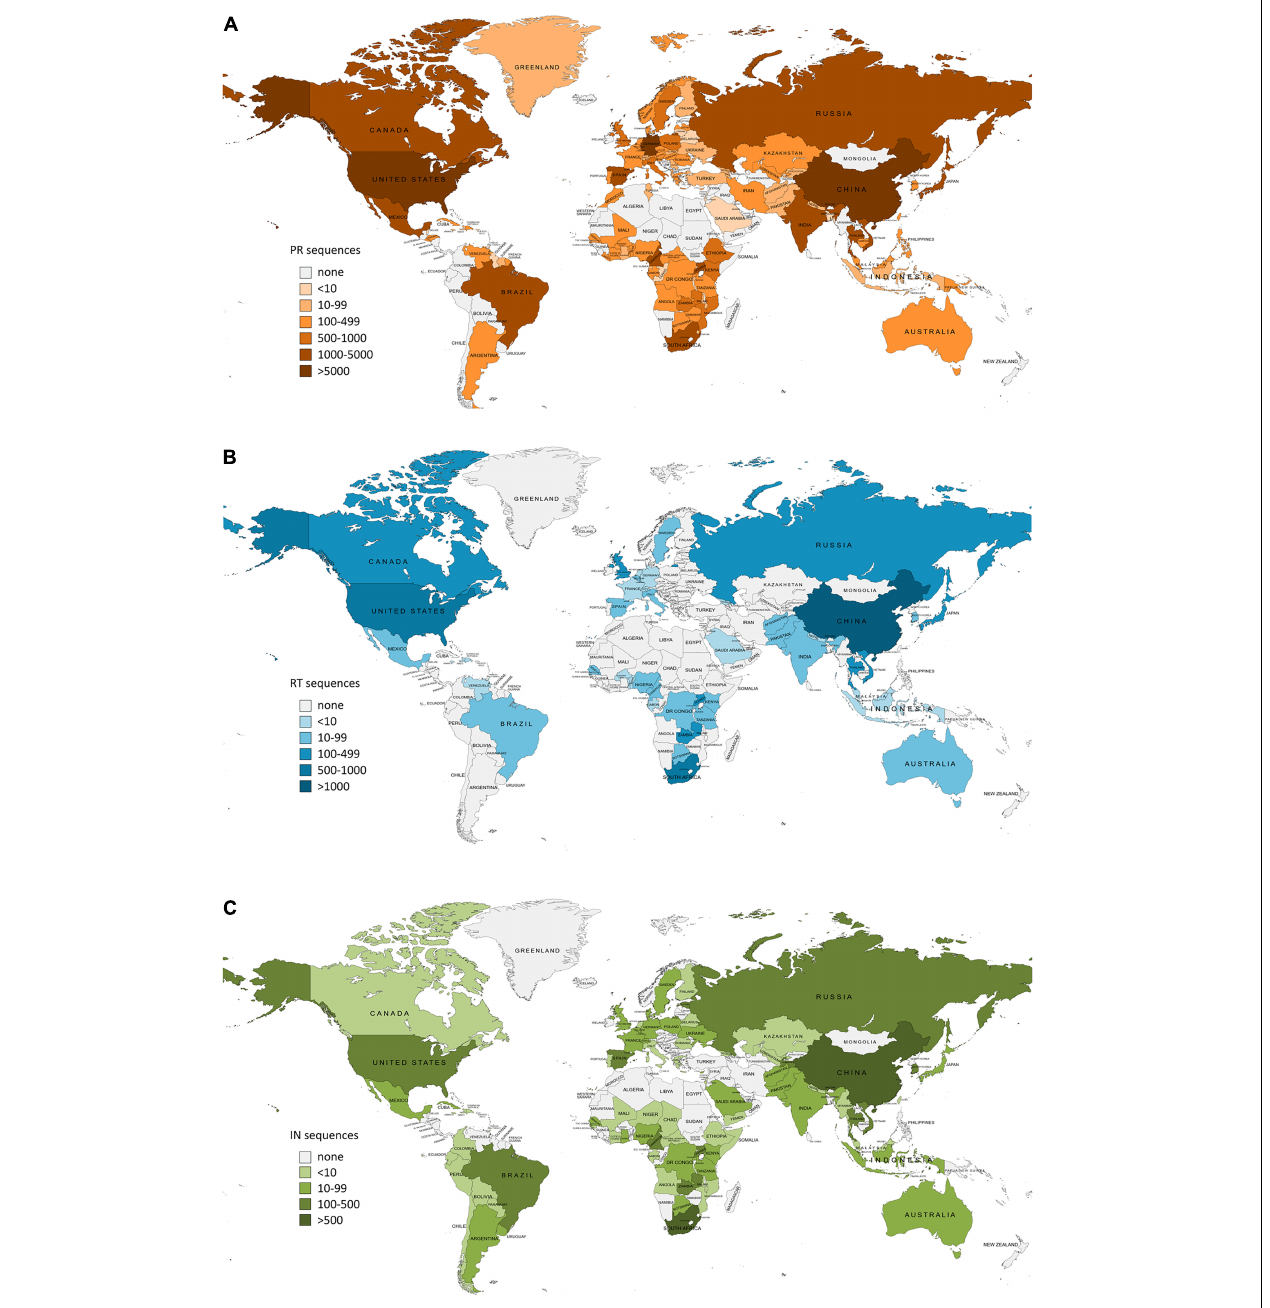
FIGURE 1 | Number of HIV-1 Pol sequences per country included in this study as available in Los Alamos HIV sequence database (LANL) in January 2022. PR, protease; RT, reverse transcriptase; IN, integrase. (A) Protease sequences per country. Total LANL sequences: 59.733. (B) Reverse transcriptase sequences per country. Total LANL sequences: 6.437. (C) Integrase sequences per country. Total LANL sequences: 6.059. Eleven integrase sequences had no record of the country of